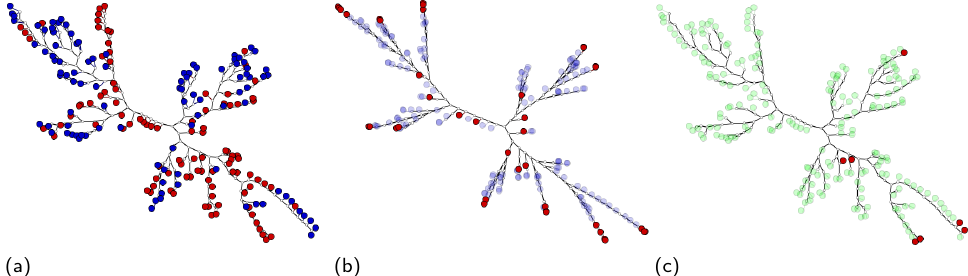
Figure 6. MILTree’s Bag Space Layout for the People Category of the Corel-1000 dataset, with the projection of its Ground truth ( a ), selected training set ( b ) and InstancePrototypes ClassMatch tree ( c